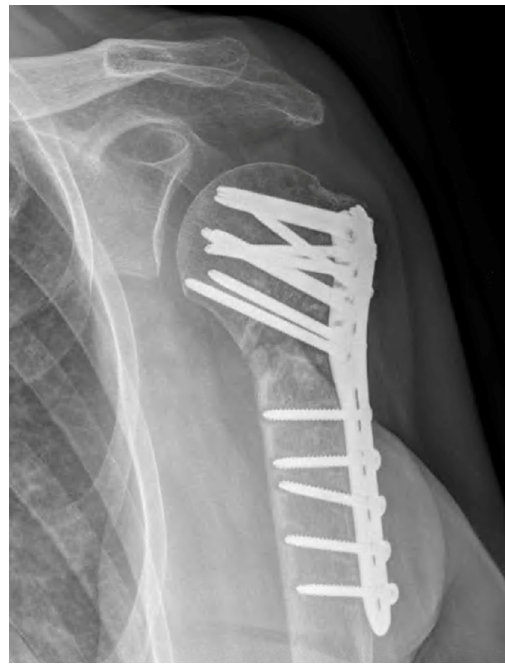
Figure 3. True AP view of the left shoulder approximately 15 months from undergoing revision ORIF and bone grafting of a surgical neck nonunion of the proximal humerus. There is evidence of early hardware failure (screw pullout), graft resorption, and persistent nonunion of the surgical